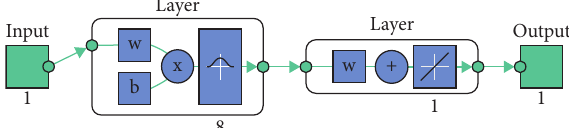
Figure 6: Neural network diagram for original training dataset [14].